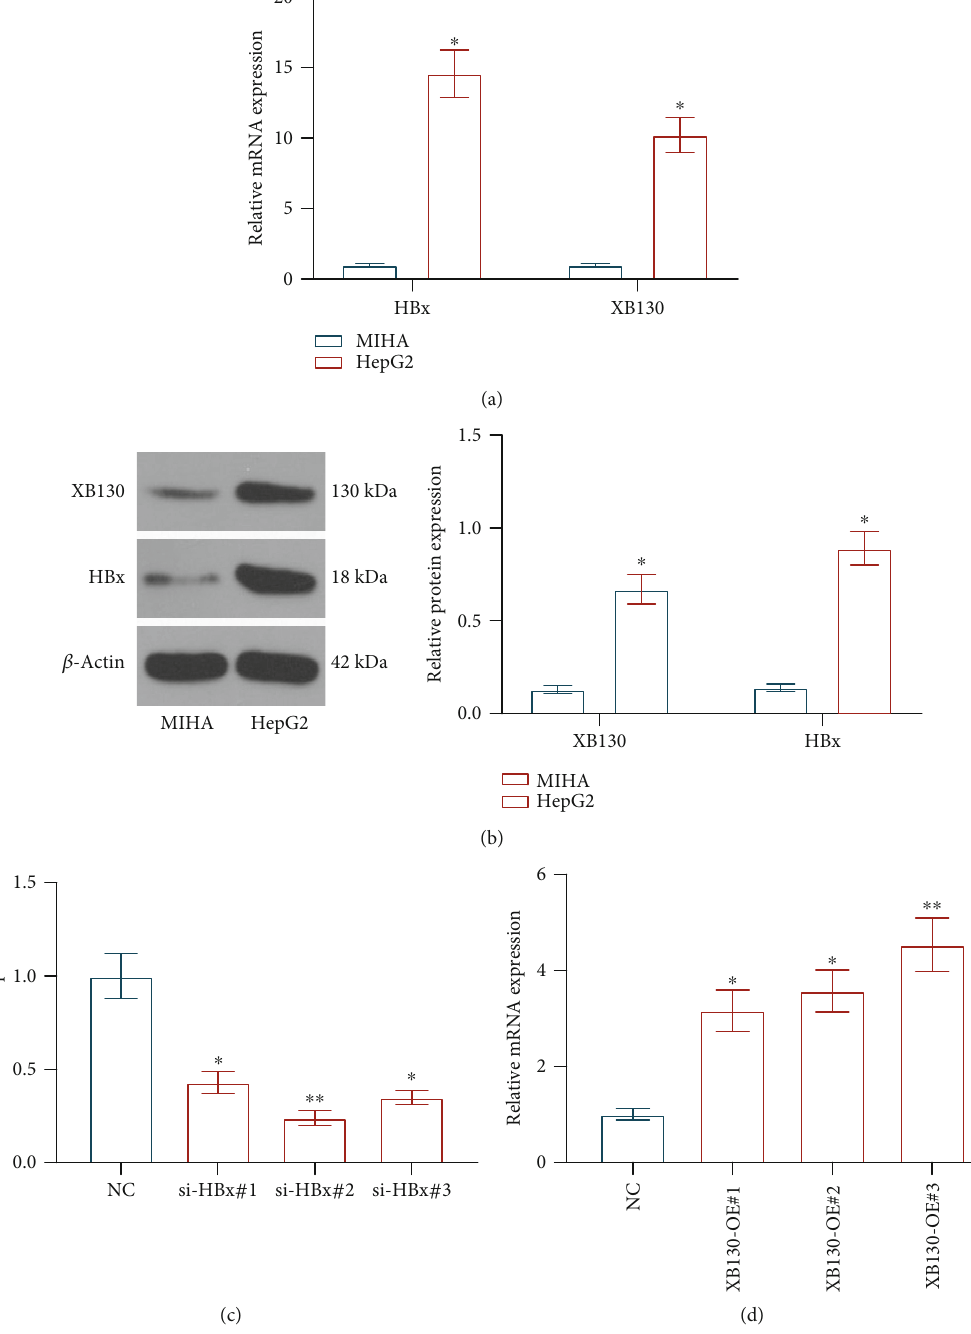
Figure 2: Expression of HBx/XB130 in liver cancer cells and normal hepatocytes. (a) Expression of HBx/XB130 in HepG2 and MIHA cells determined by RT-qPCR. (b) Protein levels of HBx/XB130 in HepG2 and MIHA cells analyzed by Western blot analysis. (c, d) Transfection e ffi ciency of pcDNA 3.1 plasmids containing si-HBx or XB130-OE evaluated by RT-qPCR. ∗ p < 0 : 05 and ∗∗ p < 0 : 01